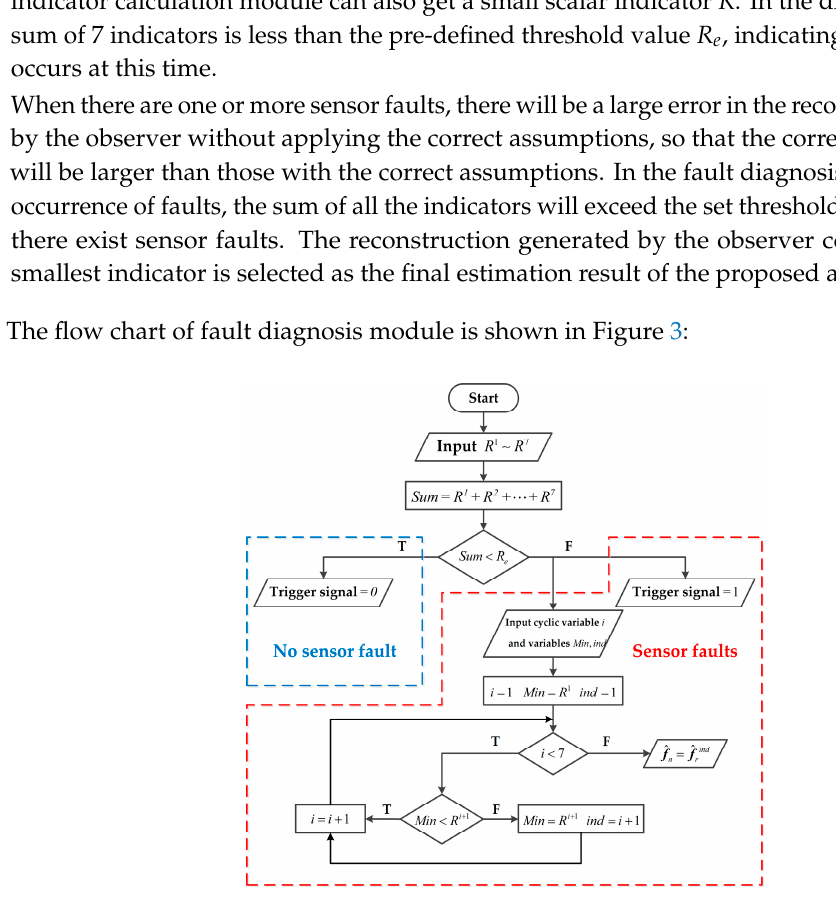
Figure 3. Flow chart of fault diagnosis module.